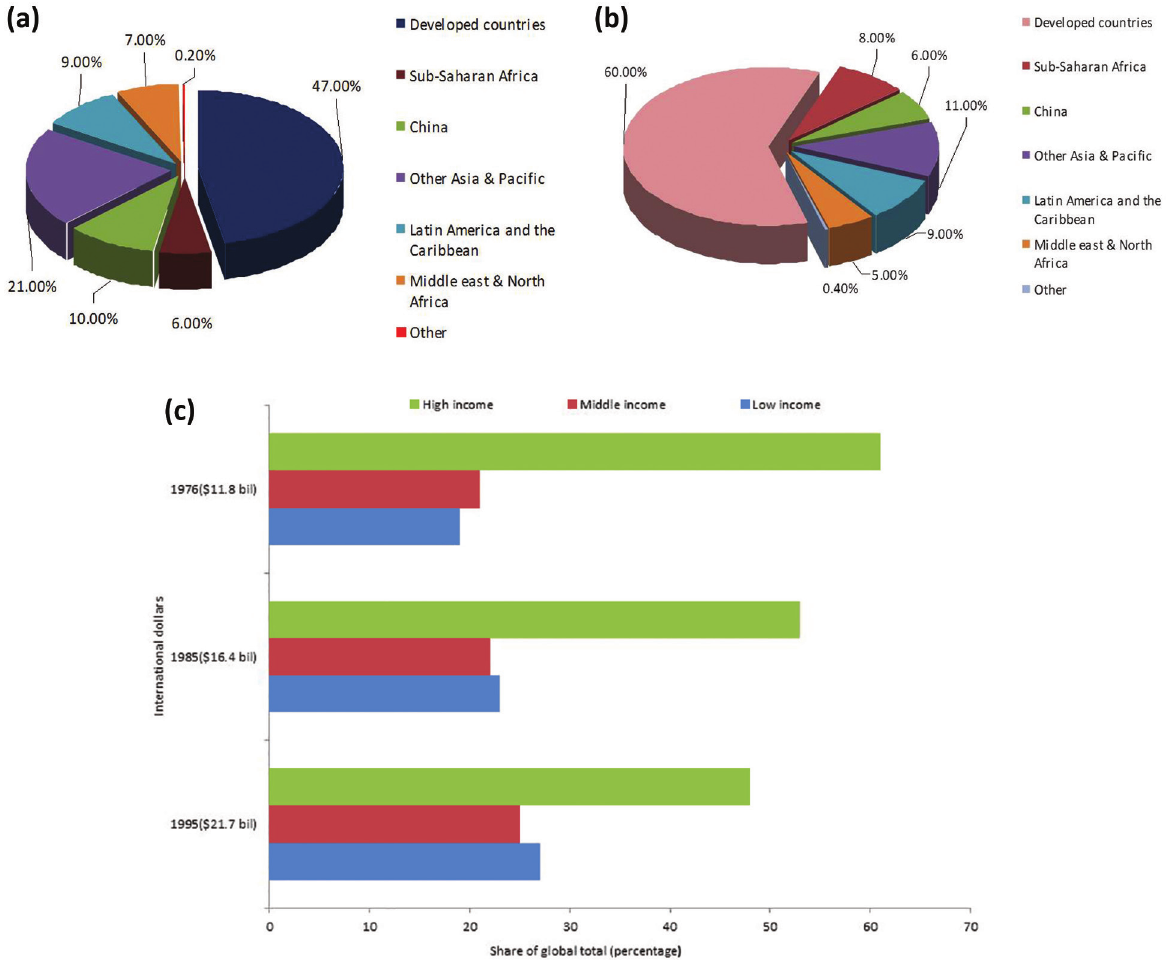
Figure 5 - a , b : Regional share in public agricultural research expenditures, 1976 and 1995, c : Public agricultural research spending by income class, 1976-1995. Note: Low income= < $726 per capita/year. Middle income= $726-8,955 per capita/year. High Income= > $ 8,955 per capita/year. Source: MSF